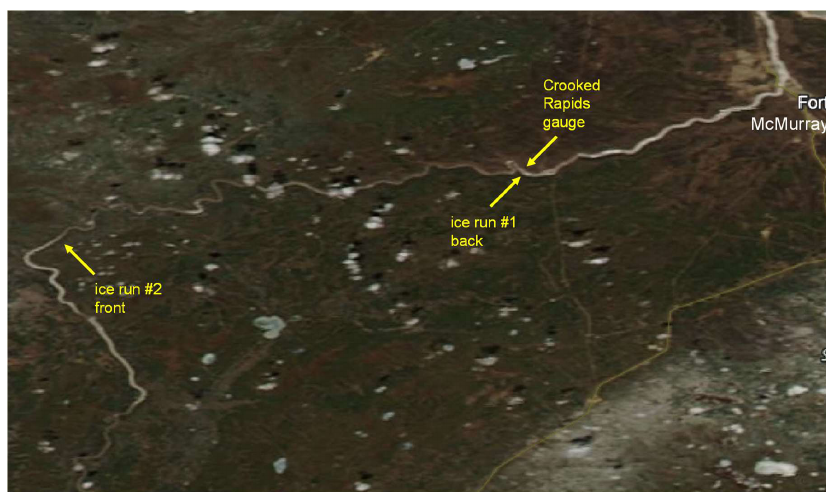
Figure 7. MODIS Terra image acquired 26 April 2018 11:35 MST.